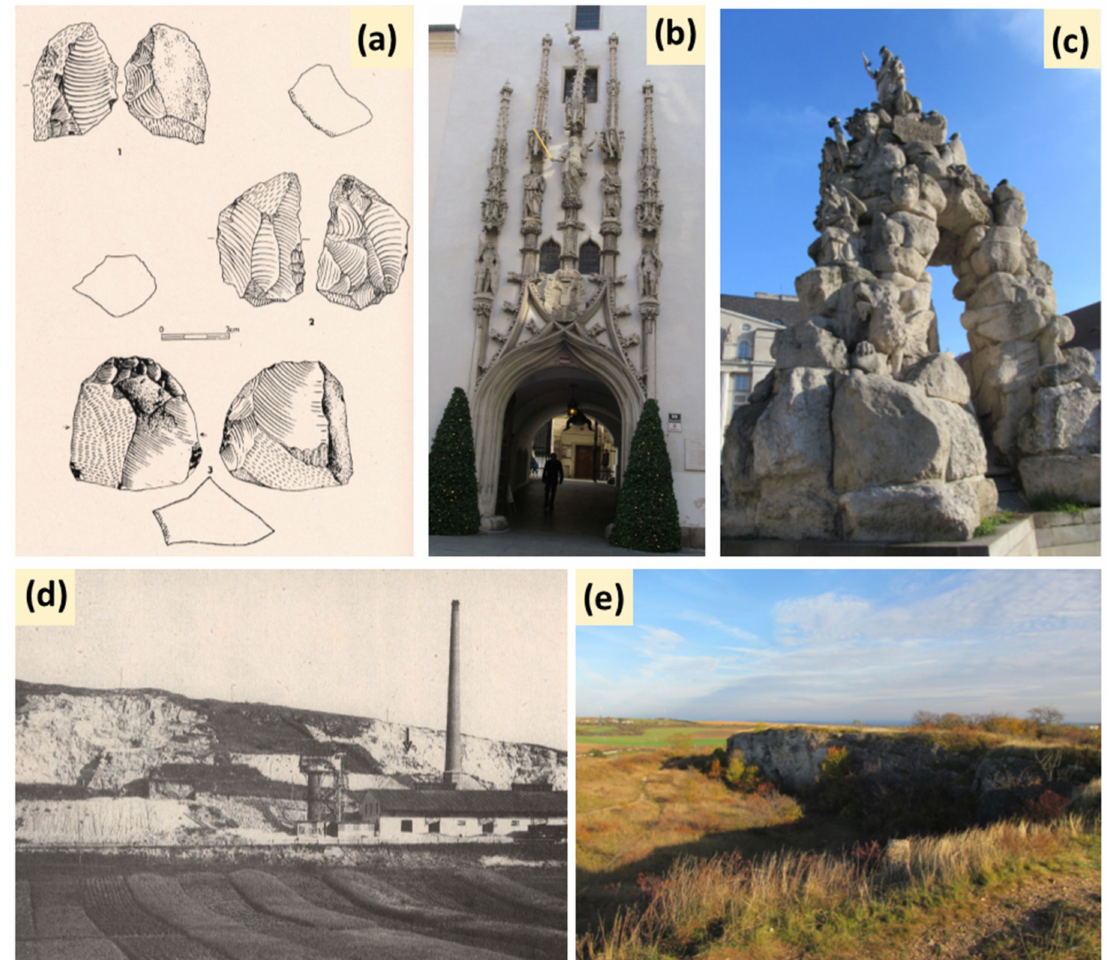
Figure 3. Geo-cultural issues of Str á nsk á sk á la: ( a ) Stone artifacts from the Cromerian age—the testimony of Neolithic settlements; ( b ) Example of the use of the Crinoidea limestone—portal of the Old Town Hall; ( c ) Use of limestone on Parnas Fountain at Zeln ý Trh Market; ( d ) Str á nsk á sk á la at the beginning of 20th Century when individual quarries were still in operation; ( e ) A mosaic of rock outcrops, grasslands and bushes contributes to the aesthetical qualities of the site. Sources: ( b , c , e )—personal collection; ( a , d )—Musil ed.